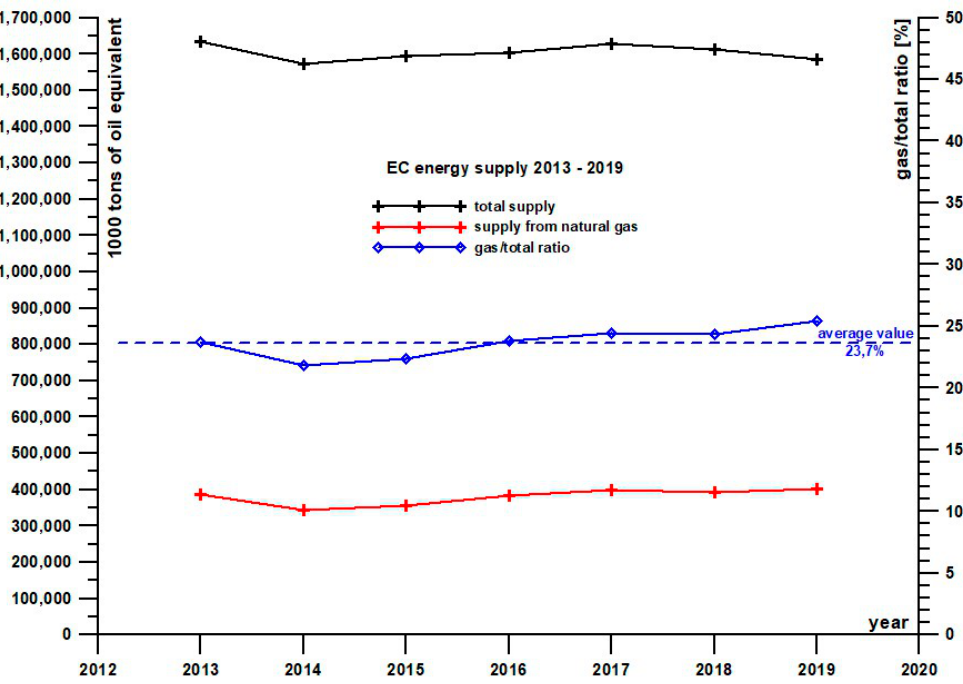
Figure 1. Energy obtained from natural gas compared with total energy obtained by the 28 European Union member states in 2013–2019 (in thousand tonnes of oil equivalent); according to EUROSTAT: 10 February 2021 [1].